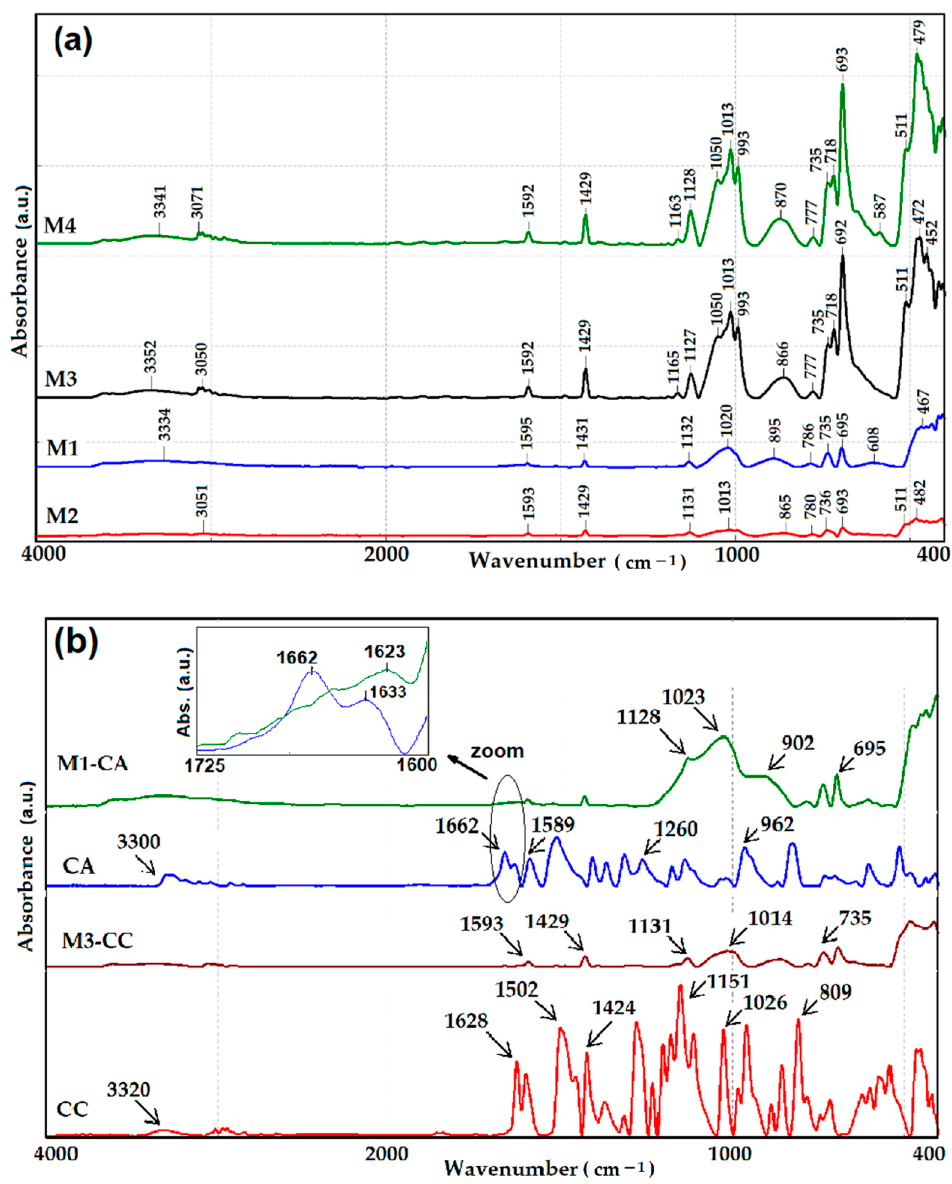
Figure 3. ATR-FTIR spectra of siloxane-type host matrices ( a ) and spectra of pure dyes and dyes embedded in matrices ( b ).